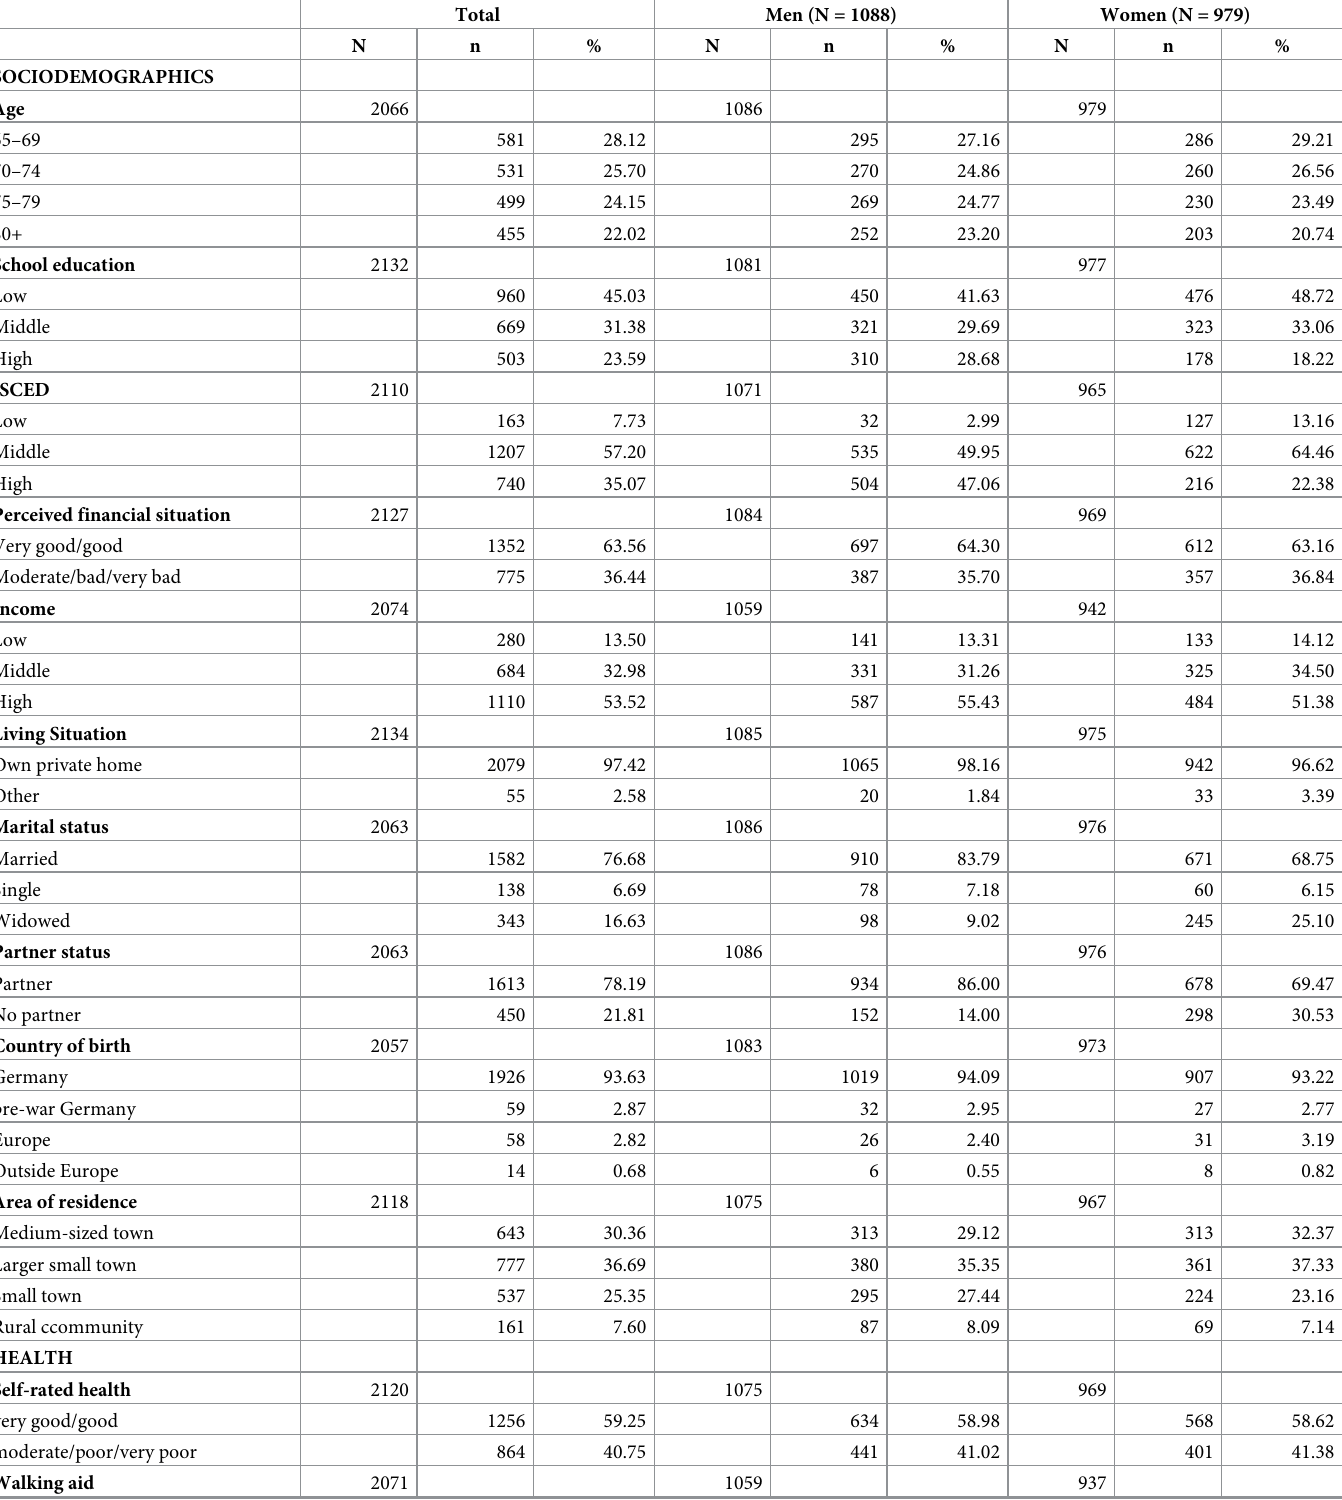
Table 1. Study characteristics for the total sample (N = 2144) and stratified by